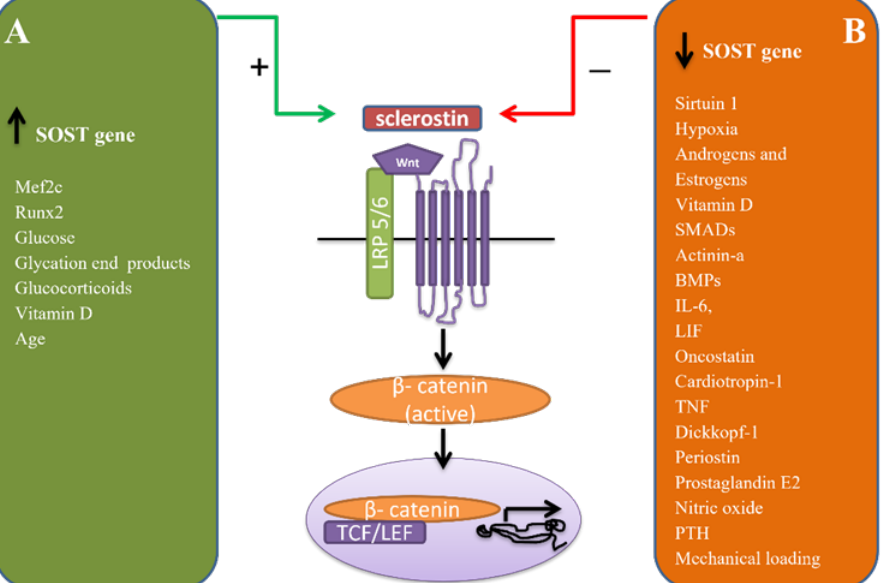
Figure 2. ( A ) Factors that upregulate SOST -gene expression. ( B ) Factors that down-regulate SOST - gene expression. Mef2c: myocyte-enhancer factor, Runx2: runt-related transcription factor 2, BMPs: bone morphogenetic proteins, IL-6: interleukin-6, LIF: leukemia inhibitory factor, TNF: tumor necrosis factor, LRP 5/6: low-density lipoprotein receptor-related protein 5/6, TCF: transcription factor, LEF: lymphoid enhancer-binding factor, PTH: parathyroid hormone.